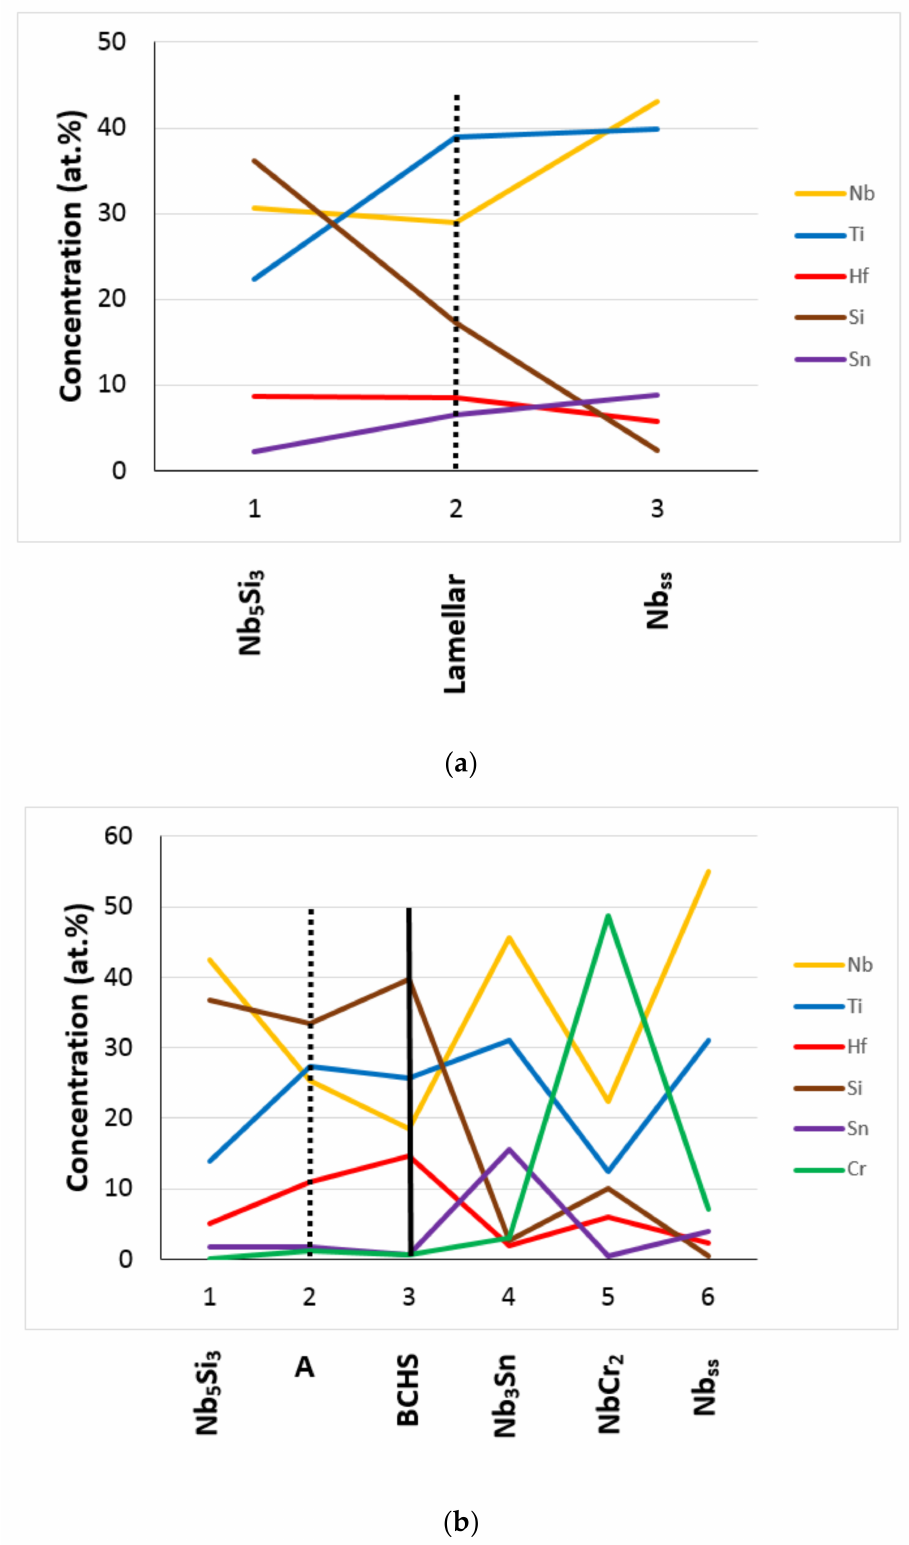
Figure 19. Average solute concentrations from Nb 5 Si 3 towards the Nb ss ( a ) for the lamellar mi- crostructure in EZ2-AC and ( b ) the microstructure A in EZ6-HT2. In ( b ), BCHS = bright contrast hexagonal silicide. The data in this figure is not from a line scan; instead, it is quantitative analysis data from microstructures like those in the Figures 2 and 8. The A15-Nb 3 X is shown as Nb 3